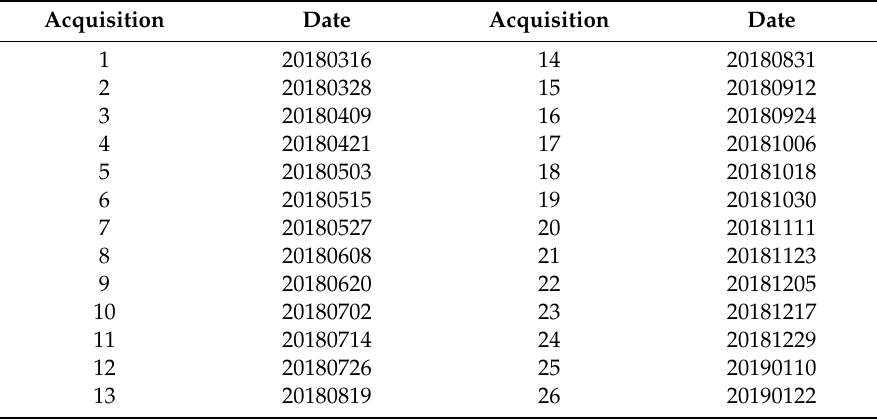
Table 1. Acquisition time of the Sentinel-1B